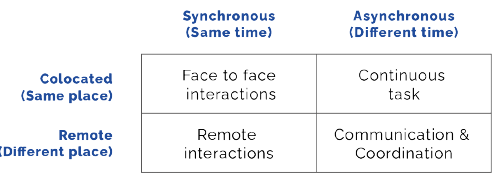
Figure 3. Johansen’s (1988) space-time matrix that classifies the key contexts for tech-supported collaboration (figure redrawn). As Figure 3 demonstrates, Johansen’s (1988) model treats four spatiotemporal contexts: whether the collaboration takes place in one place (colocated) or in different places (remote), and